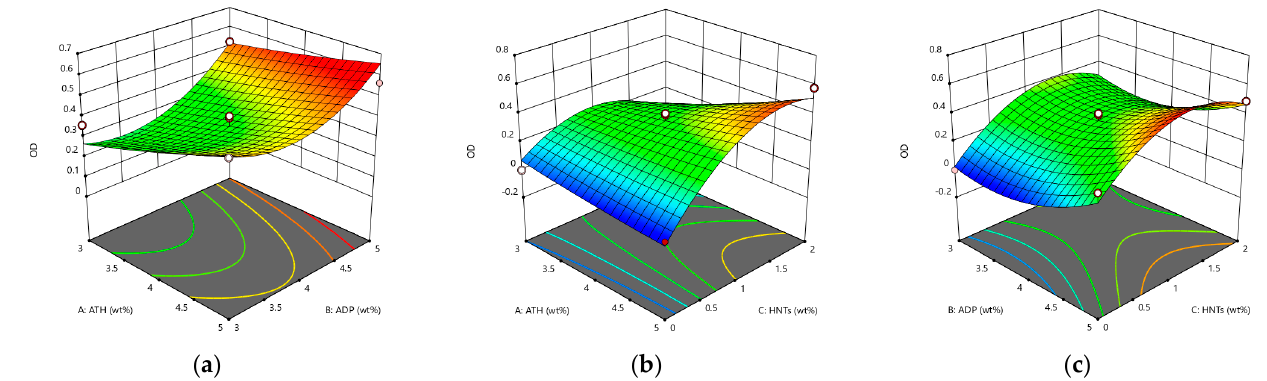
Figure 6. The response surface diagram of the flame retardant system to the change of OD value model: ( a ) Interactive effects of ATH and ADP; ( b ) Interactive effects of ATH and HNTs; and ( c ) Interactive effects of ADP and HNTs.